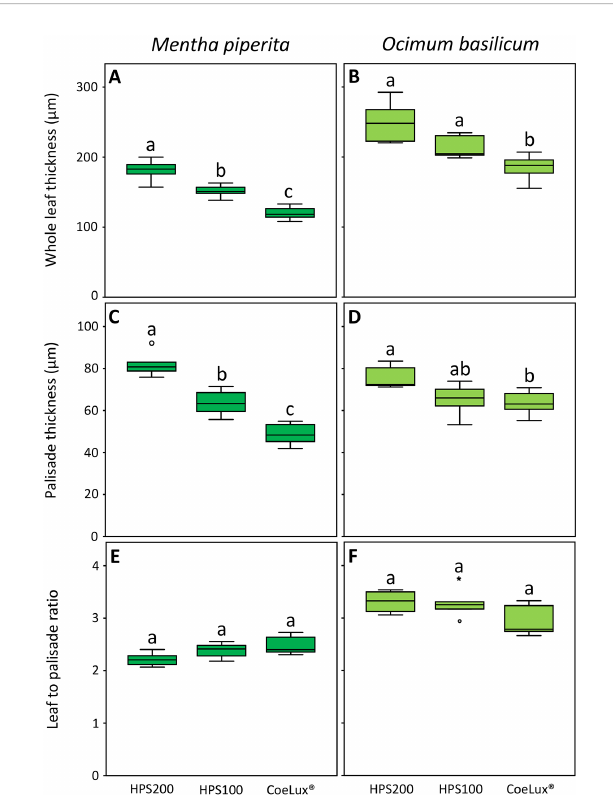
FIGURE 7 (A, B) whole leaf thickness (µm), (C, D) palisade thickness (µm), and (E, F) leaf-to-palisade ratio measured under different light treatments for Mentha piperita (dark green) and Ocimum basilicum (light green) plants. Box plots represent n=6 biological repeats while letters represent statistically signi fi cant differences (p< 0.05). Vertical boxes represent approximately 50% of the observations and lines extending from each box are the upper and lower 25% of the distribution. Within each box, the solid horizontal line is the median value. Circles and asterisks represent respectively outliers and extreme